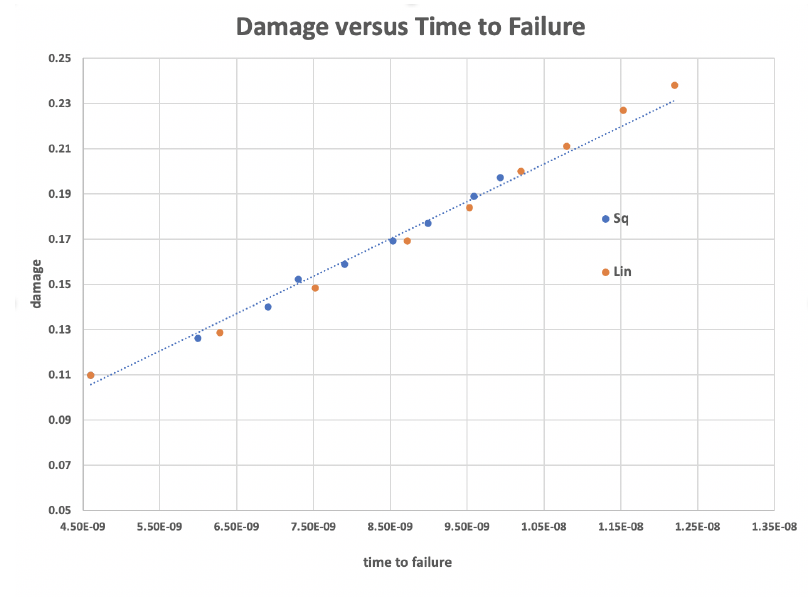
Figure 10. Damage at time of failure is plotted versus time to failure for ˙ ϵ = 1 × 10 5 s − 1 , an ensemble size of 50 and the process zone is 10% of crack radius. This plot is a synthesis of the data in Figures 7 and 8 when cell width is eliminated. The curve shows points representing both shapes fall on the same straight